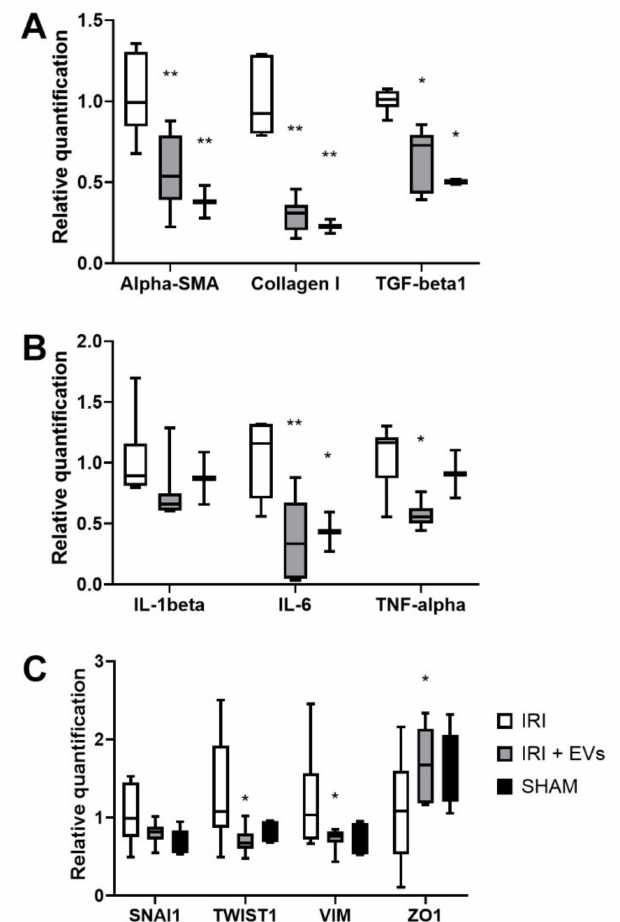
Figure 3. The effect of HLSC-EVs on fibrosis development in a renal IRI murine model. ( A – C ) Real- time PCR analysis of the expression of pro-fibrotic ( alpha-SMA, collagen I, and TGF-beta ) ( A ), of pro-inflammatory ( IL-1beta, IL-6 , and TNF-alpha ) ( B ), and of EMT genes ( SNAI1, TWIST1, VIM , and ZO1 ) ( C ) in kidneys of the SHAM control mice (SHAM, n = 5) and of IRI-mice that were IV-injected with HLSC-EVs (IRI+EVs, n = 8) or with the vehicle alone (IRI, n = 8). The mean ± SD was calculated using the ∆∆ Ct method, by comparing the gene expression levels of each group with the ones of the IRI group. Normalization was performed using GAPDH as the housekeeping gene. Statistical analysis was performed using ANOVA with Tukey’s multicomparison test: * p < 0.05, ** p < 0.001 SHAM and IRI + EVs vs